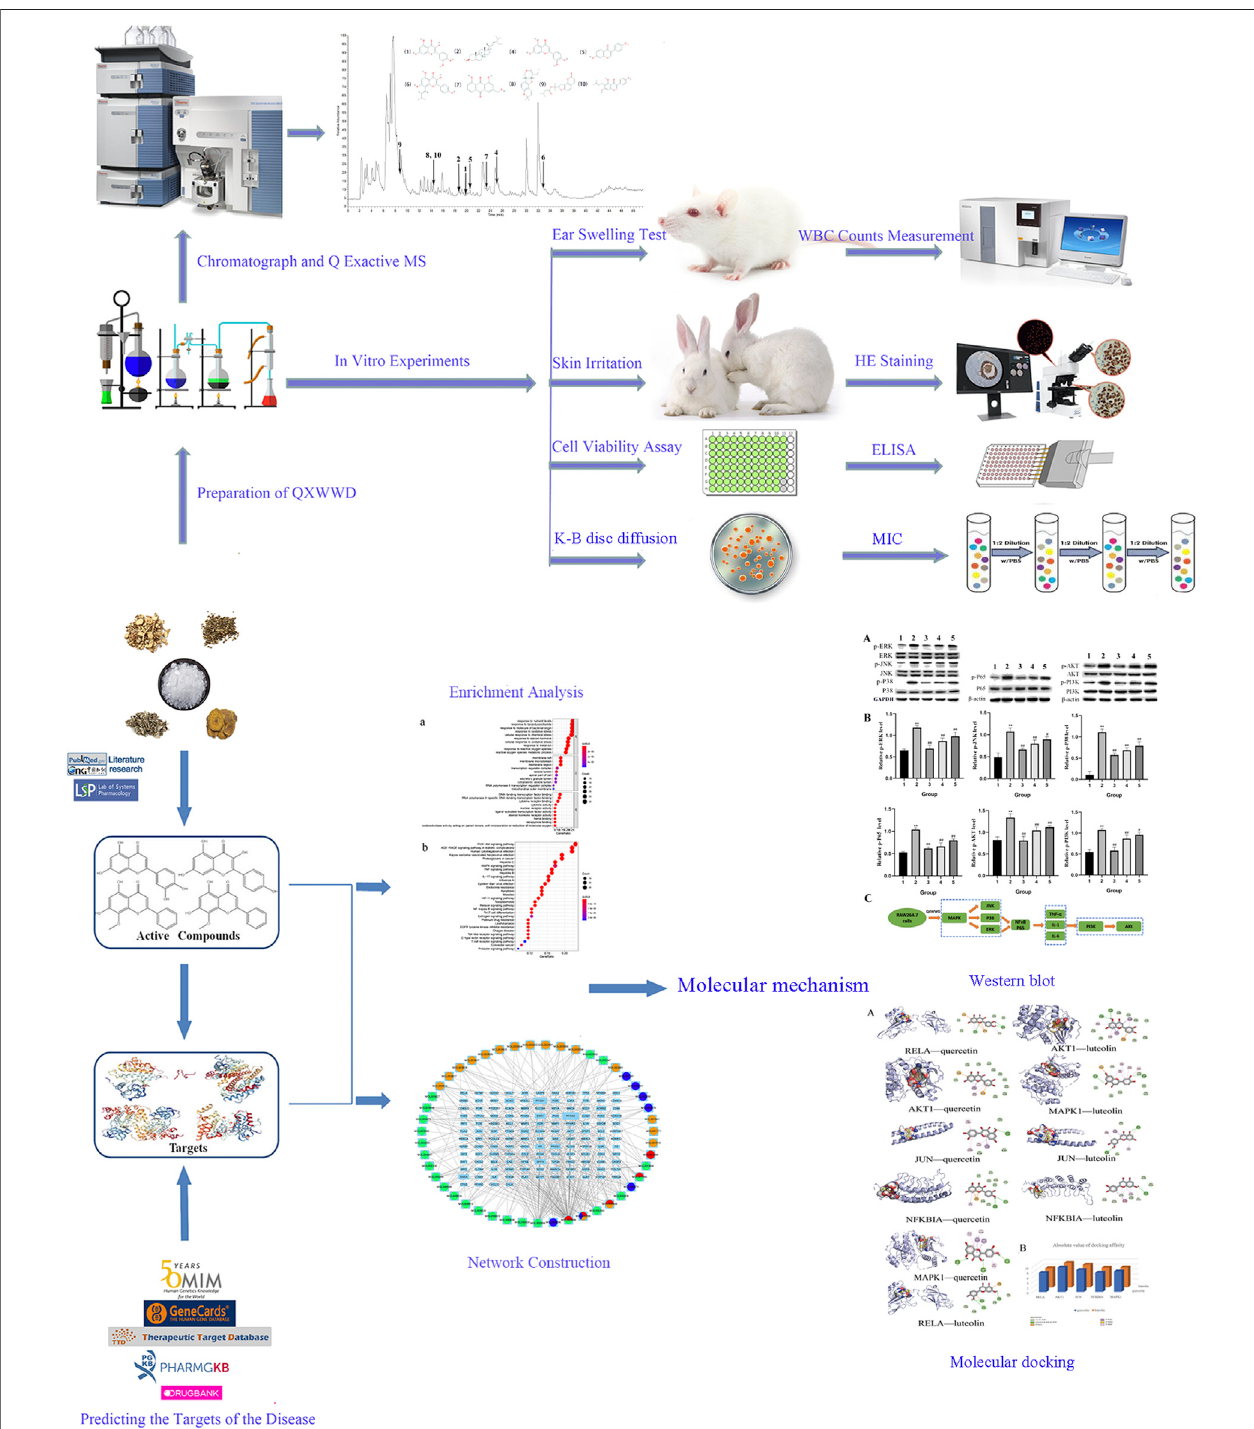
FIGURE 1 | Work fl ow for QXWWD treatment of in fl ammatory and bacterial diseases.